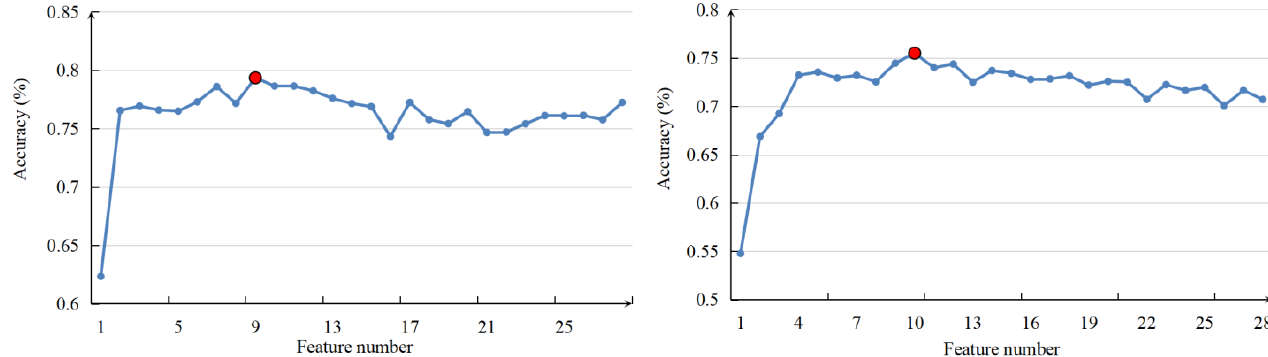
Figure 6. The RFE results of scenario-A ( left ) and scenario-B ( right ) for the training dataset. The position of the red dot indicates that the accuracy of the model was highest when the feature numbers were 9 (scenario-A) and 10 (scenario-B).